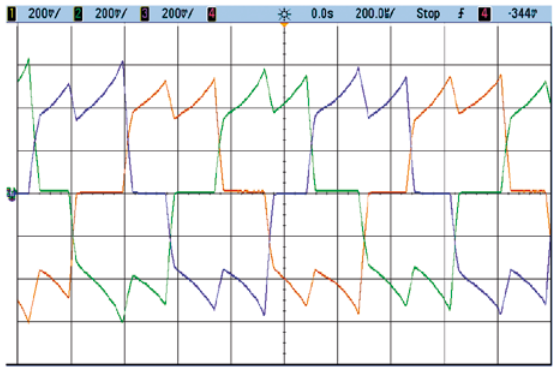
Fig. 5. Phase current waveforms of the BLDC